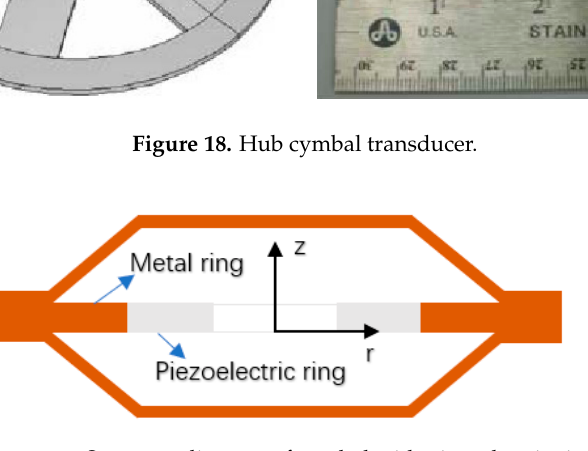
15002000 Figure 20. Influence of cavity depth. 05001000